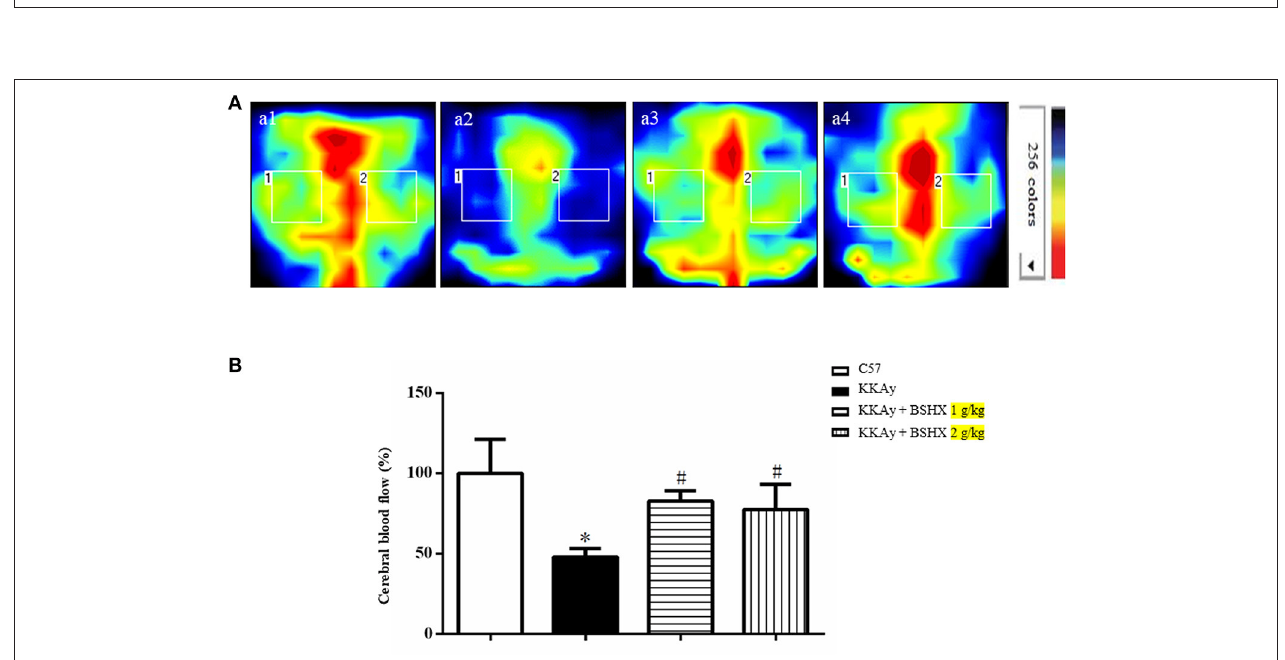
FIGURE 3 | The effect of BSHX on CBF in mouse cerebral cortex. (A) Representative images of CBF of cerebral cortex in different groups. The magnitude of CBF is represented by different colors, with blue to red indicating low to high. a1: C57 group; a2: KKAy group; a3: KKAy + BSHX 1 g/kg group; a4: KKAy + BSHX 2 g/kg. (B) Quantitative analysis of CBF in all groups. CBF was determined by the average of the square box 1 and 2, which correspond to MCA territory. Data were expressed as mean ± SD ( n = 6). * p < 0.05 vs. C57 group, # p < 0.05 vs. KKAy group.